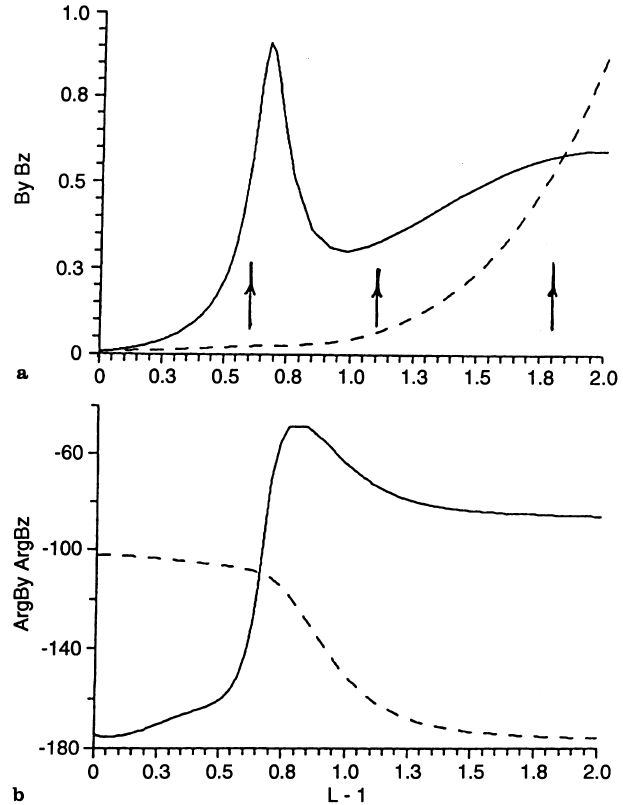
Fig. 16a,b. Numerically calculated radial distribution of the ampli- tudes B y , B z ( upper plots ) and phases Arg (cid:133) B y (cid:134) , Arg (cid:133) B z (cid:134) ( bottom plots ) of the components of ULF wave structure in the magnetosphere. Wave parameters are m (cid:136) 4, f (cid:136)